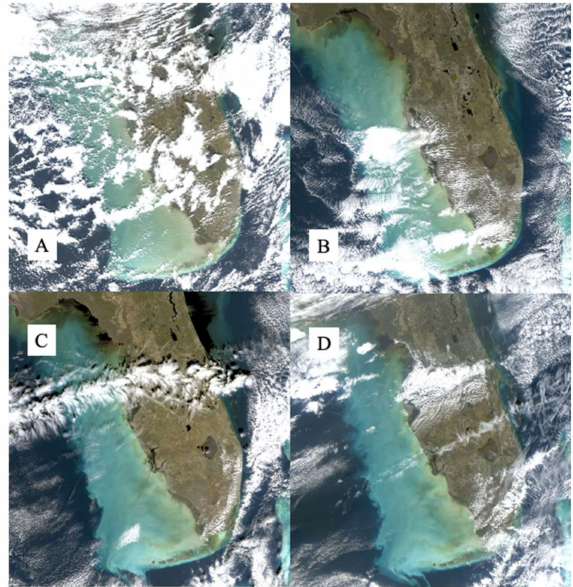
Figure 5. True color (TC) fields for the WFS derived from the Visible Infrared Imaging Radiome- ter Suite (VIIRS) sensor for ( A ) NOAA 20 on 21 December during the initial phase of the CAO event; ( B ) NOAA 20 on 22 December; ( C ) Suomi-National Polar-Orbiting Partnership (SNPP) on 23 December; and ( D ) NOAA 20 on 24 December after the cloud cover from the initial CAO phase has dissipated. The satellite platform selection for VIIRS data analysis (NOAA 20 or SNPP) is shown based on the best spatial and cloud-free coverage of the WFS for that date.